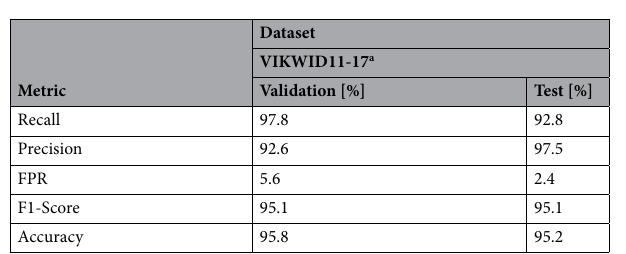
Table 5. Detection results of VVI-DETECT to filter between valid versus invalid identification images (data enhancement), while training VVI-DETECT on VIKWID11-17. a VIKWID11-17 Valid/Invalid Killer Whale Identification Dataset